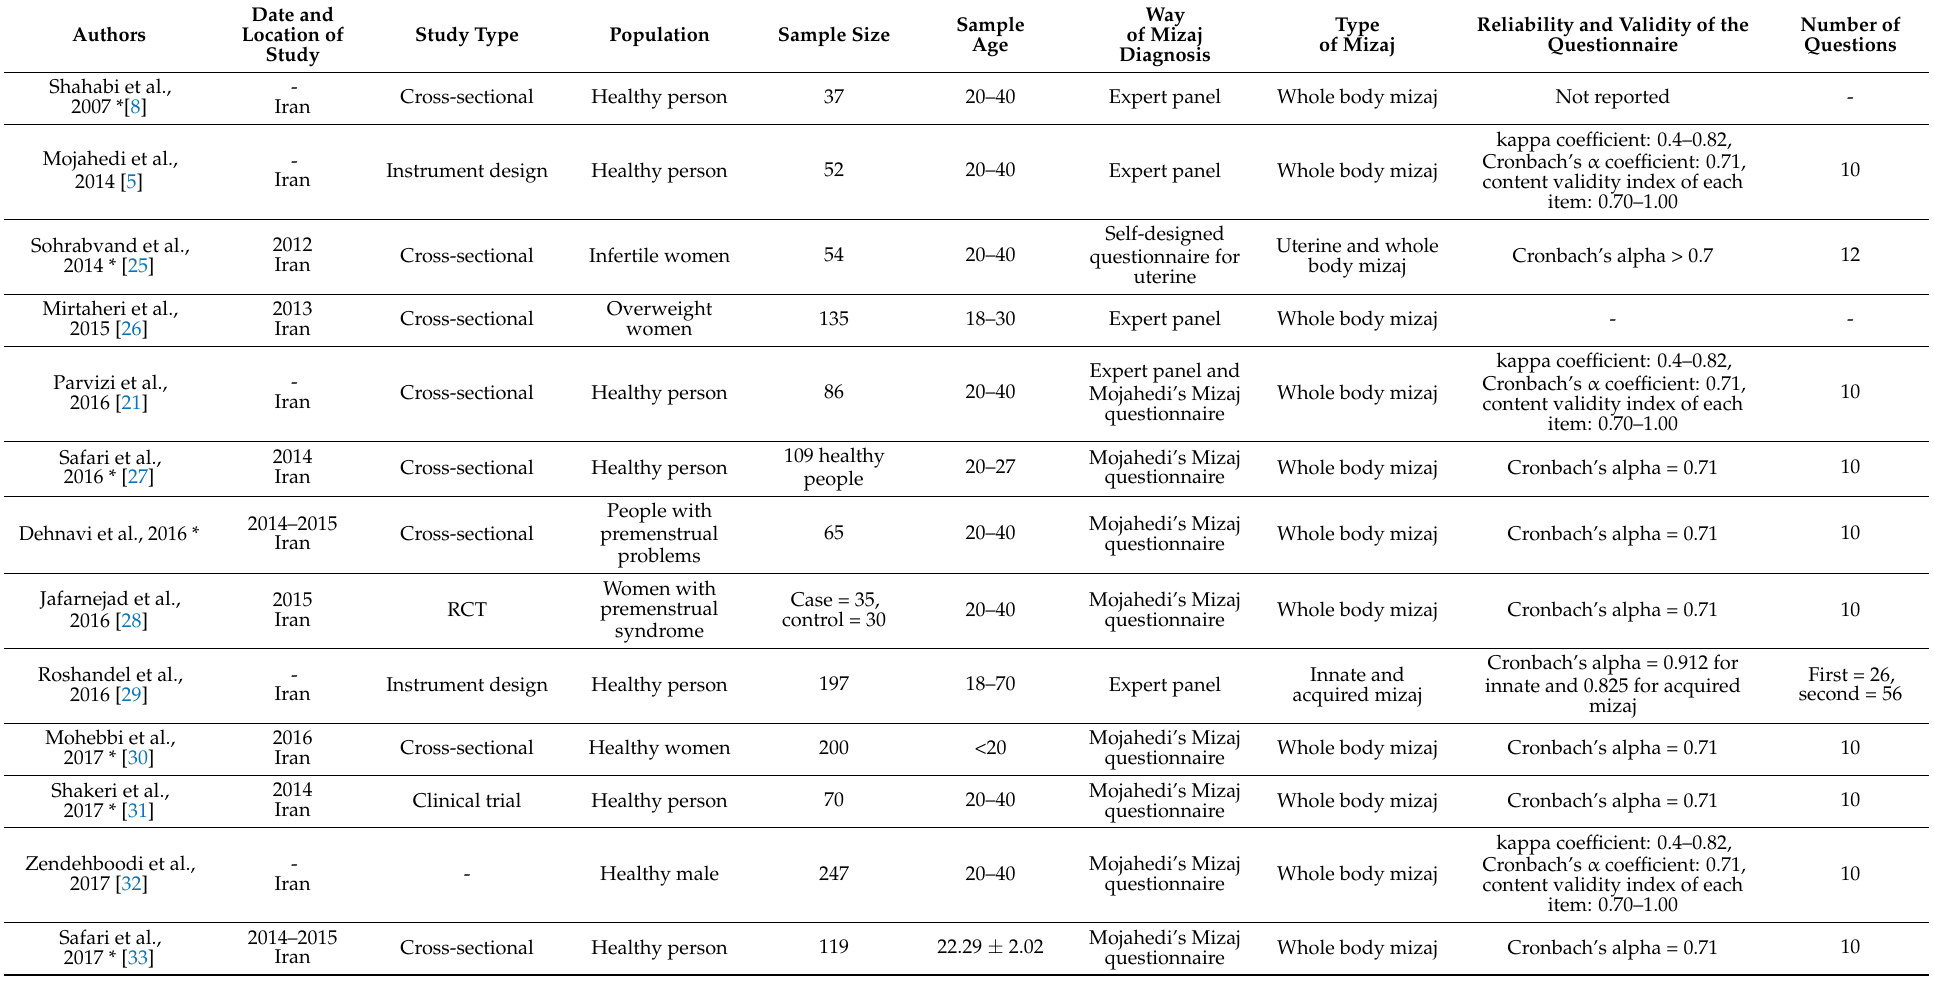
Table 1. Final included